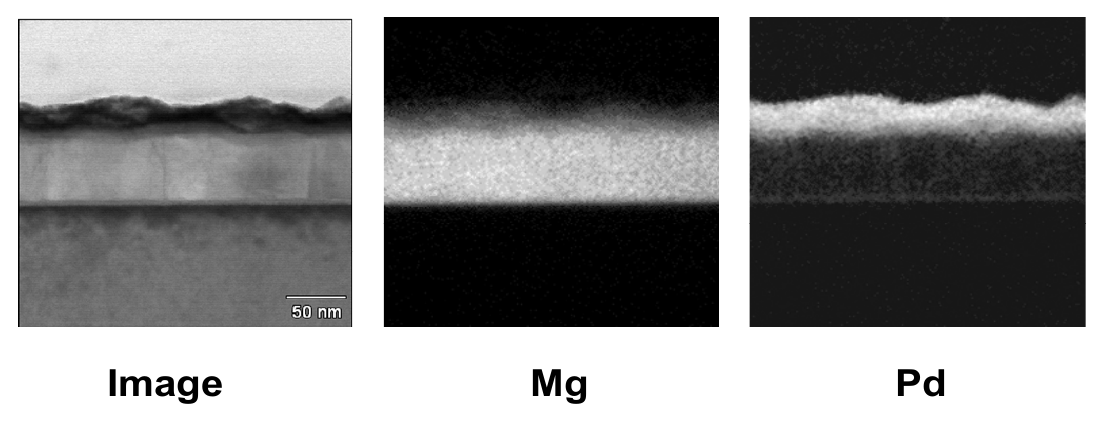
Figure 4. EDX mapping of as-deposited Pd capped Mg thin film for Mg and Pd